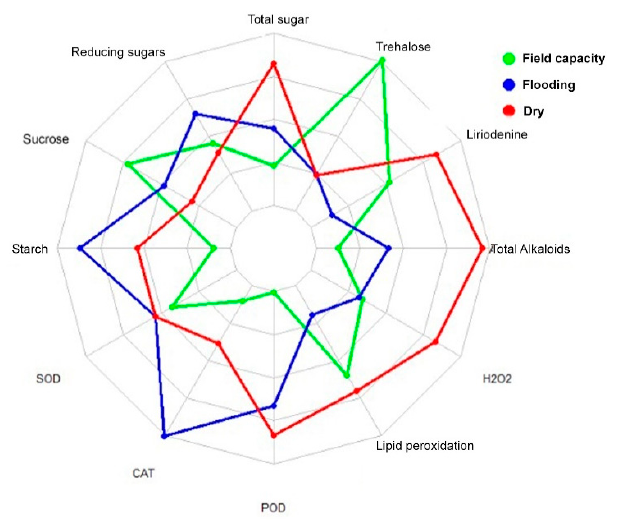
Figure 2. Biochemical variables: (liriodenine; total alkaloids; hydrogen peroxide (H 2 O 2 ); lipoperox- ide, peroxidase (POD); catalase (CAT); superoxide dismutase (SOD); starch; sucrose; reducing sugar; total sugars; trehalose) obtained from young A. crassiflora plants submitted to three water condition levels (Field Capacity ( − 0.01 MPa); Flooding; Drought ( − 1.5 MPa)) at 18 days after the beginning of treatments. *Variables represented in the graph and that showed significant differences in statistical analysis by Tukey tests at 5% are shown in Table 2.